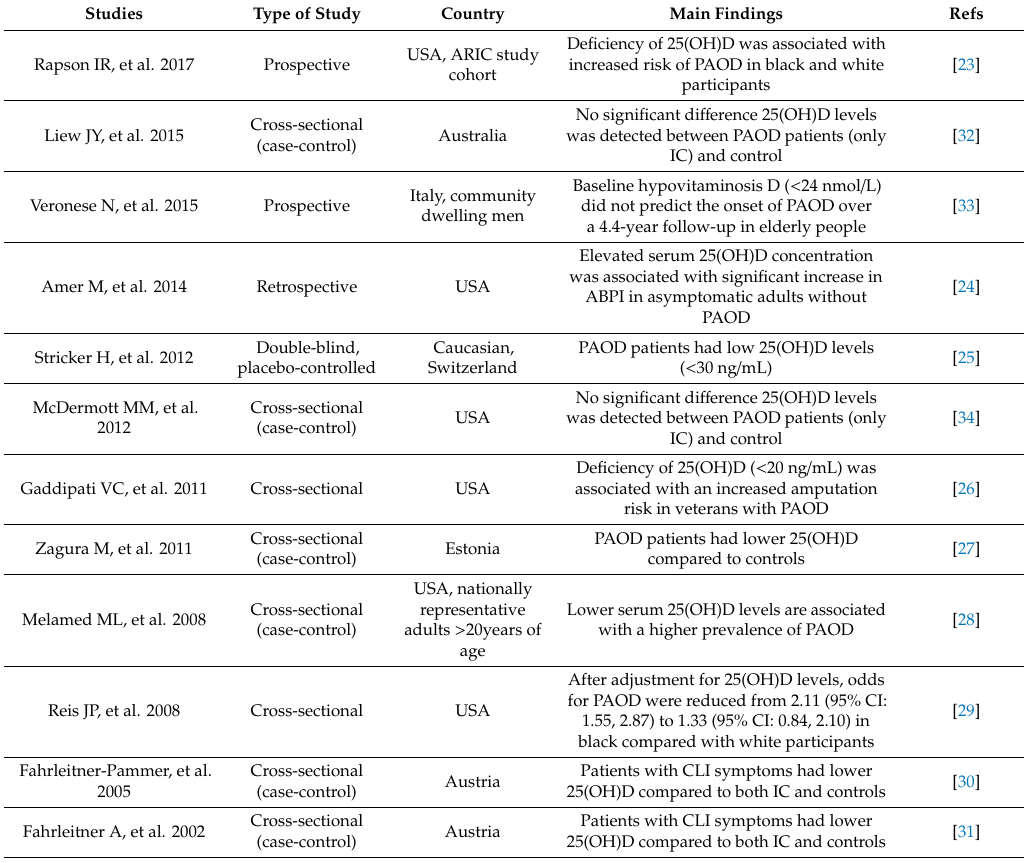
Table 1. Cross-sectional studies investigating vitamin D circulating levels in peripheral arterial occlusive disease (PAOD)